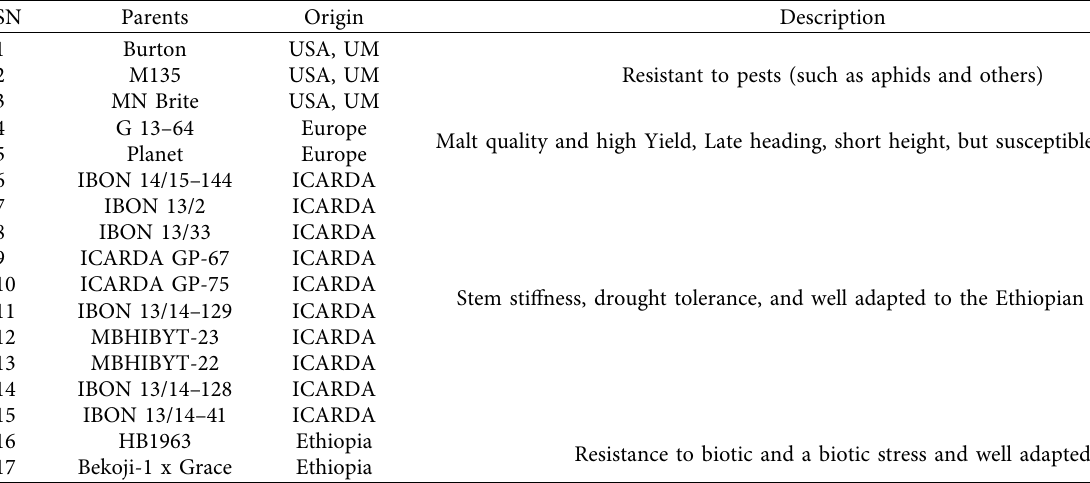
Table 1: List of the 17 parental lines, origin, and their agronomic